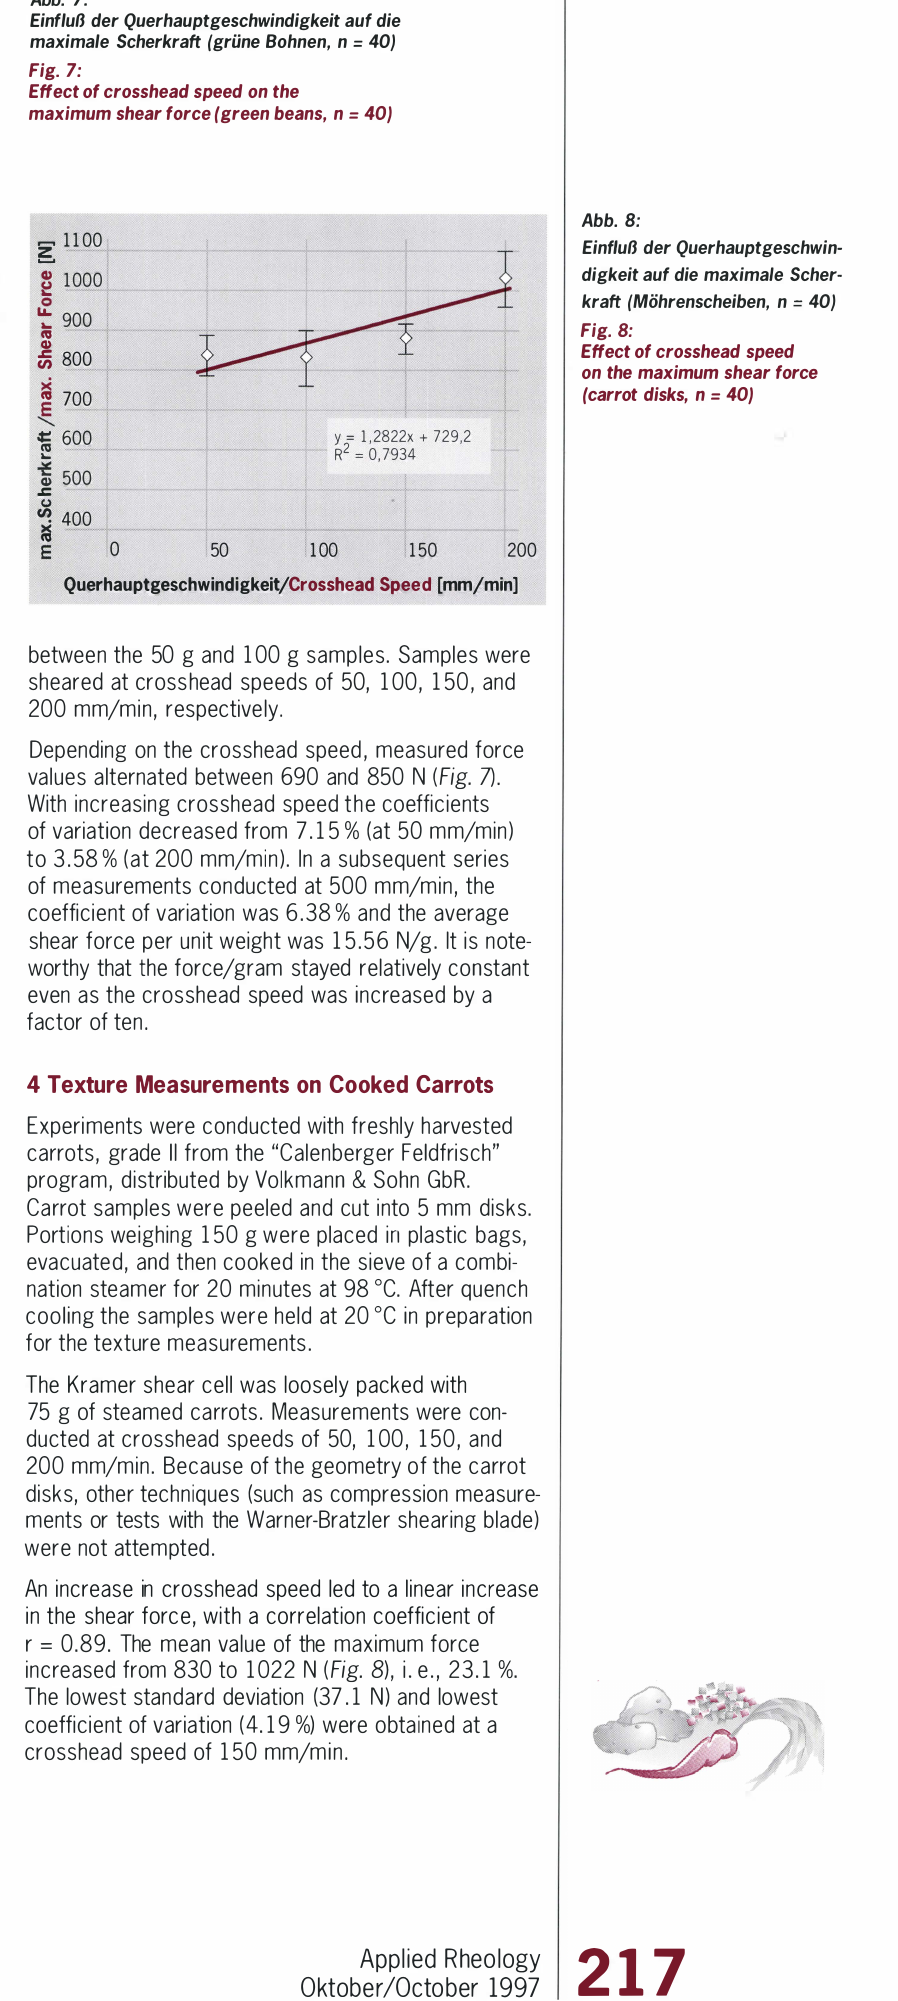
Abb. 7: EinfluB der Querhauptgeschwindigkeit auf die maximale Scherkraft (griine Bohnen, n = 40) Fig. 7: Effect of crosshead speed on the maximum shear force (green beans, n = 40)